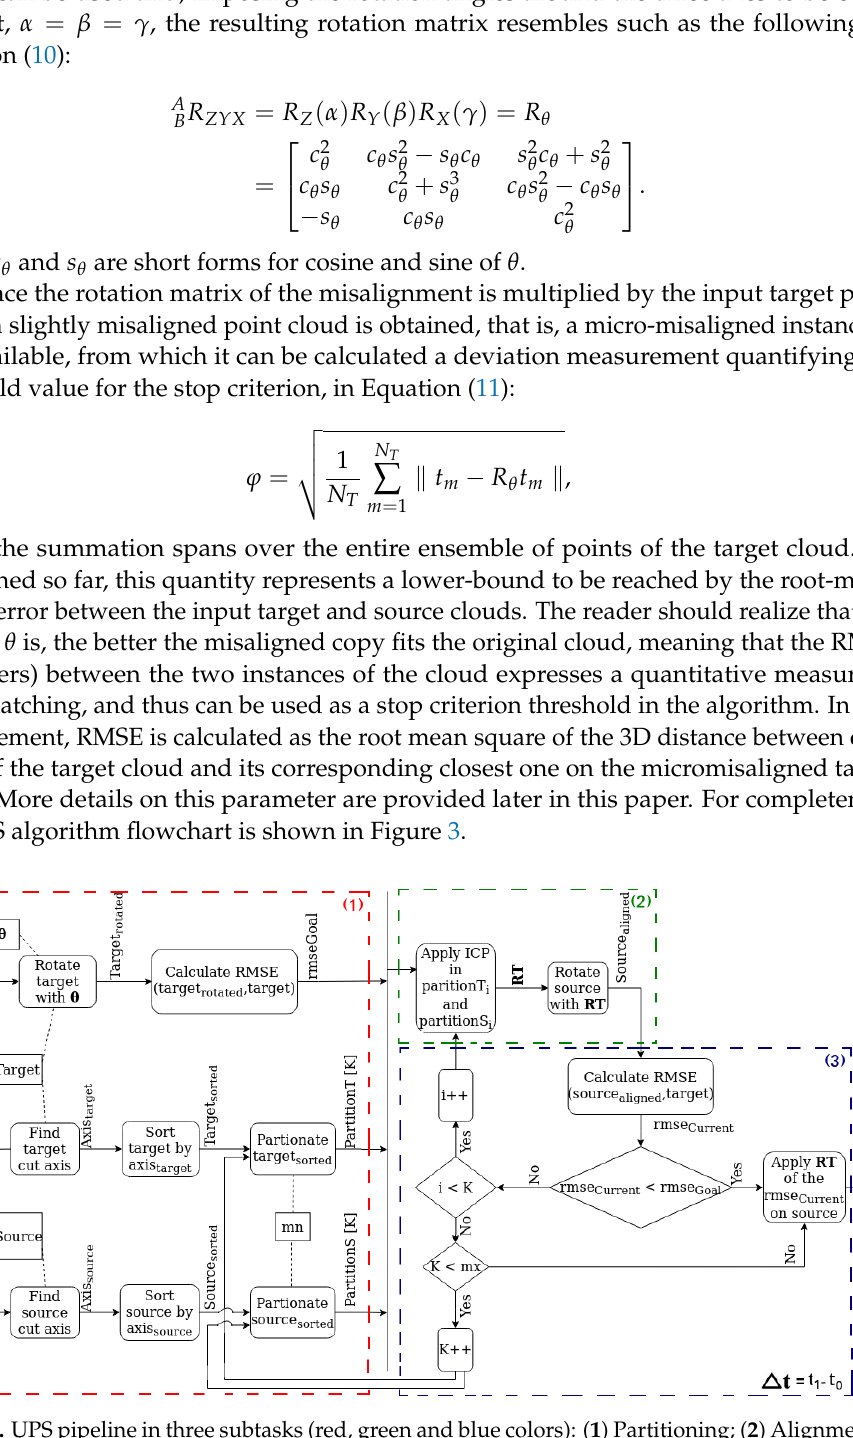
Figure 3. UPS pipeline in three subtasks (red, green and blue colors): ( 1 ) Partitioning; ( 2 ) Alignment of the subcloud pairs and ( 3 ) Quality check of alignment and replication of the local rigid transformation to the entire cloud. Parameter ∆ t represents the running time in the entire execution of the algorithm and is the quantity present in the tables reported later in Section 6. Finally, mn and mx are, respectively, the minimum and the maximum number of points per